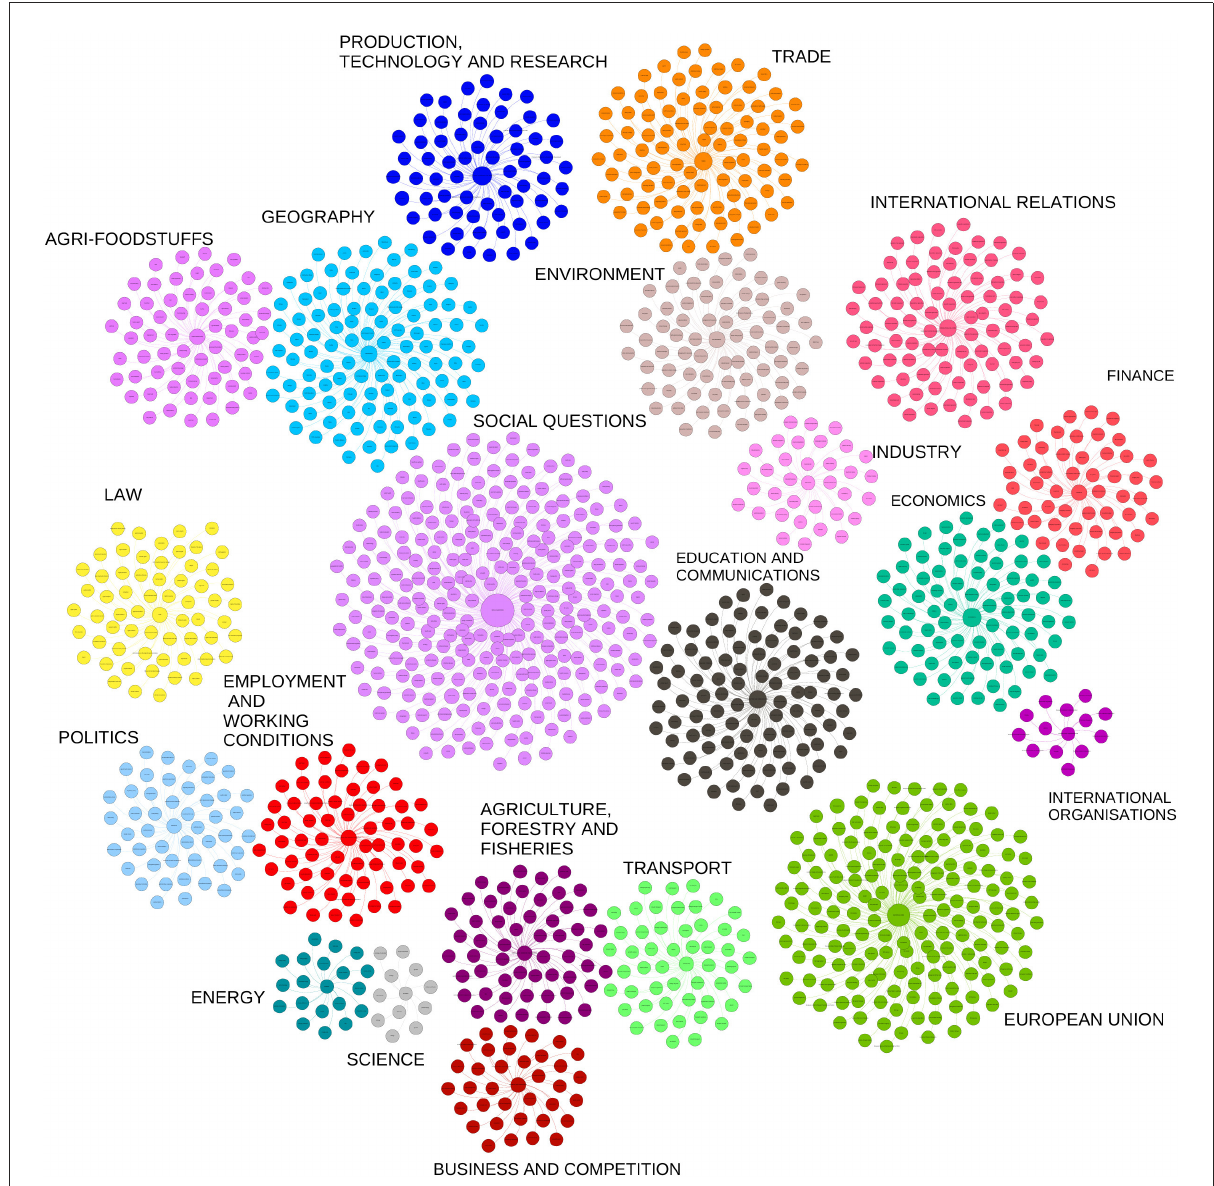
FIGURE2 Cluster structure of EuroVoc classifications. Legend, EuroVoc terms are represented by a network analysis in form of clusters. Each cluster represents a EuroVoc domain. In the center of the cluster the domain node is located, and each branch (edge) represents a subdomain. The size of the node depends on how often the term is used in the